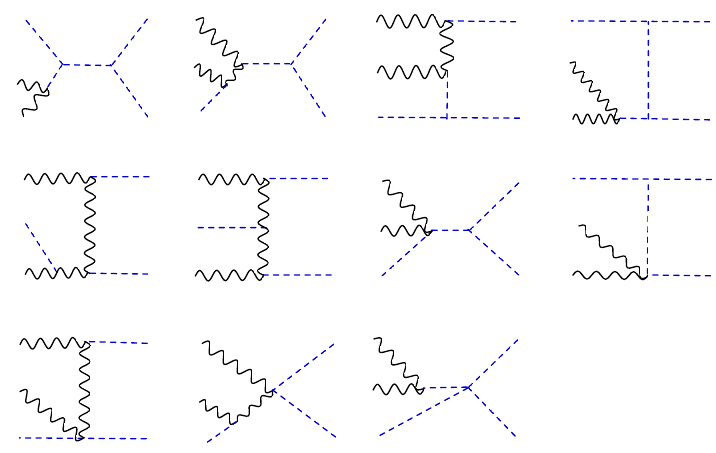
Figure 12 . Feynman diagrams for the annihilation XXS ! SS .